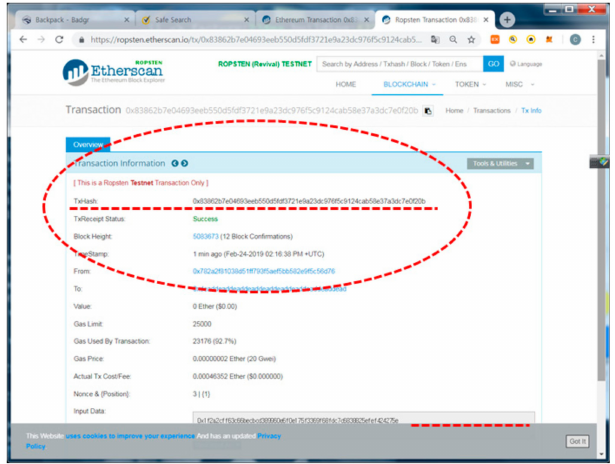
Figure 20. A Transaction example on Ethereum after blockchain based digital badge award.